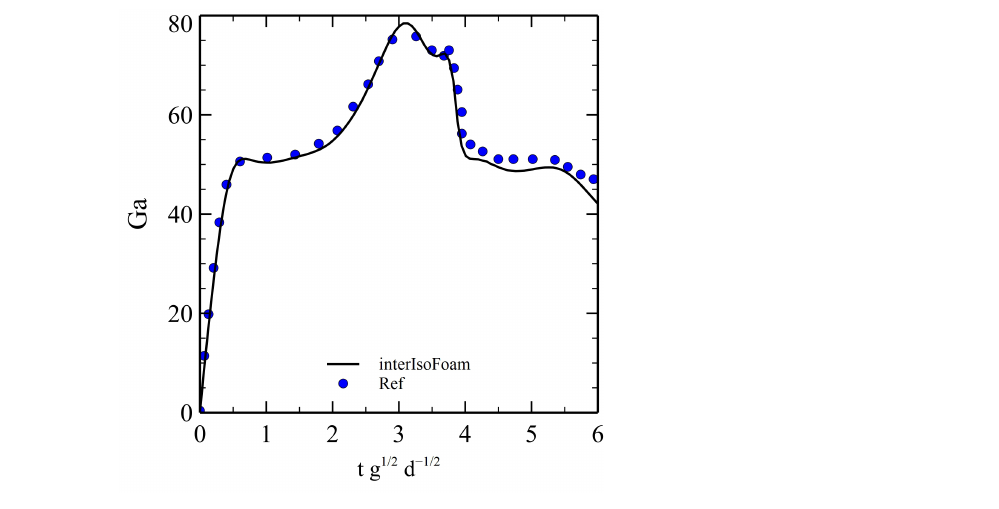
Figure 13. Evolution of Ga for the coalescence case provided by plicRDF compared with Ref. [10].